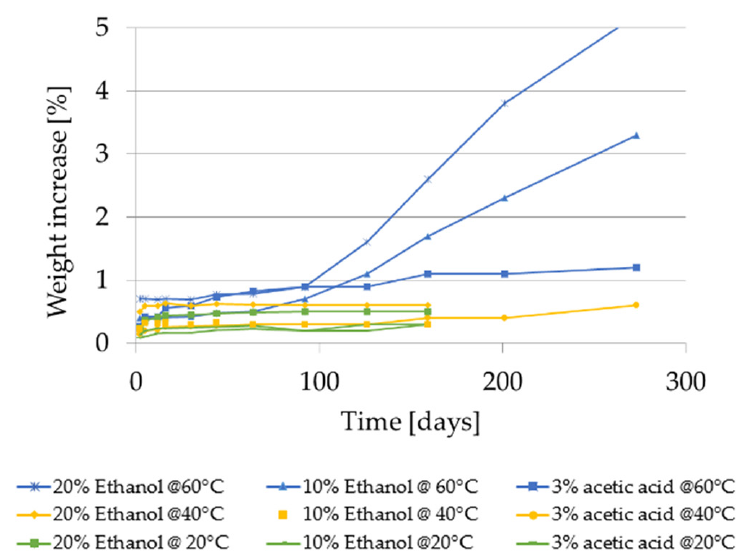
Figure 10. Weight increase of GPPS in 20% ethanol at 20, 40 and 60 ◦ C for storage times up to